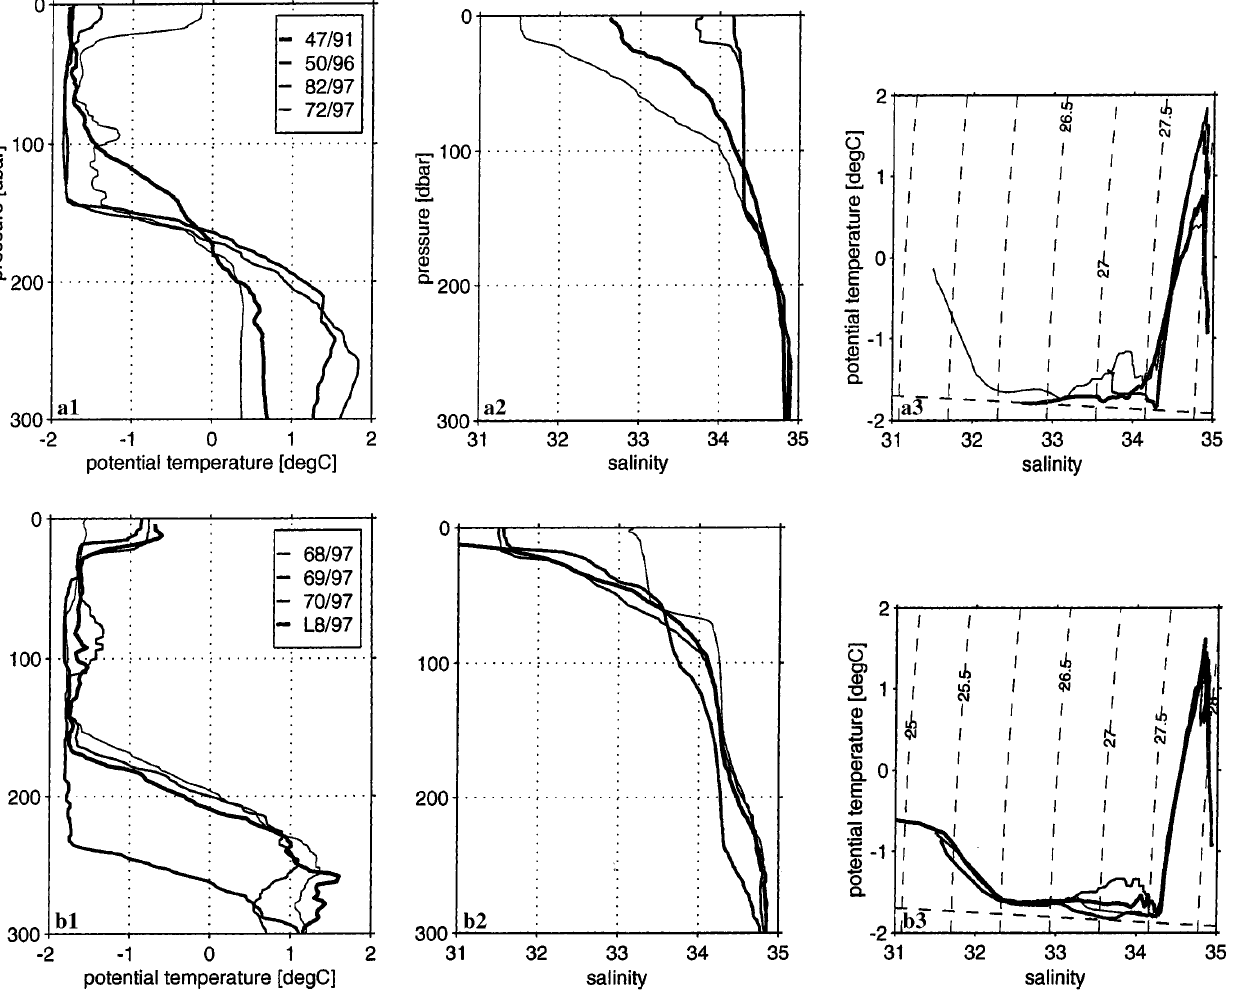
b profiles of potential temperature ( b1 ) and salinity ( b2 ) for the upper 300 m, and Q -S curves ( b3 ) showing the di(cid:128)erent depth of the winter mixed layer on section II ( 68/97 , 69/97 and 70/97 ) and in the western part of section I (